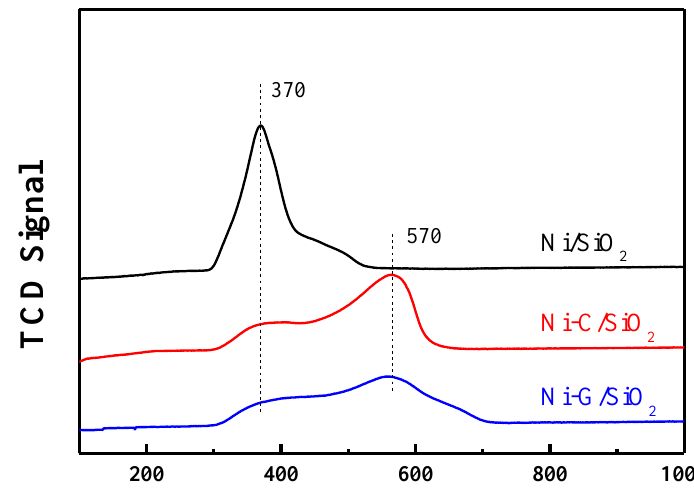
Figure 3. H 2 -TPR patterns for the catalysts.